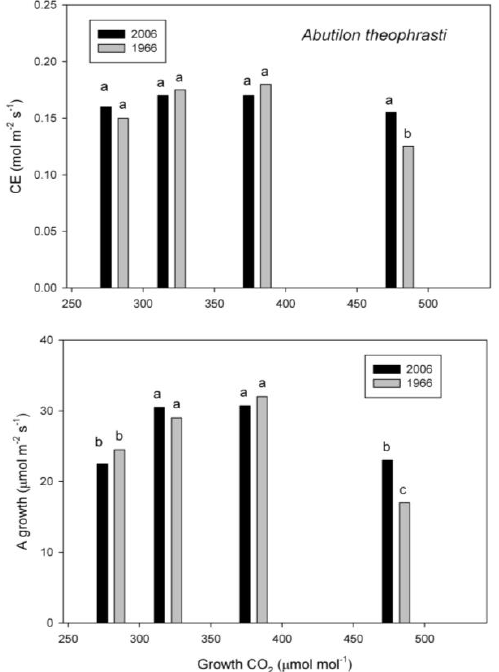
Figure 2. Carboxylation efficiency (CE) and assimilation rate (A) under the growth conditions in Abutilon theophrasti grown at four CO 2 concentrations from seeds collected in 1966 and 2006. Different letters indicate significant differences, based on analysis of variance.